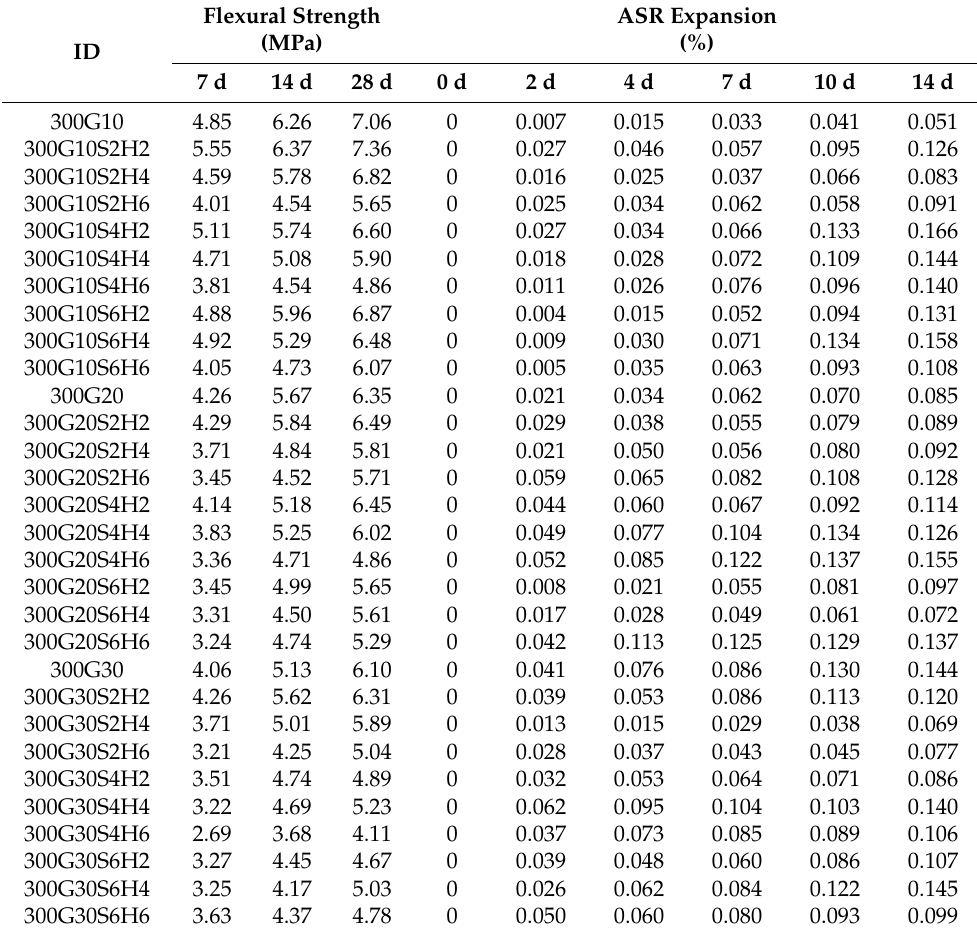
Table A2. The experimental results of 300 µ m WGP mortar